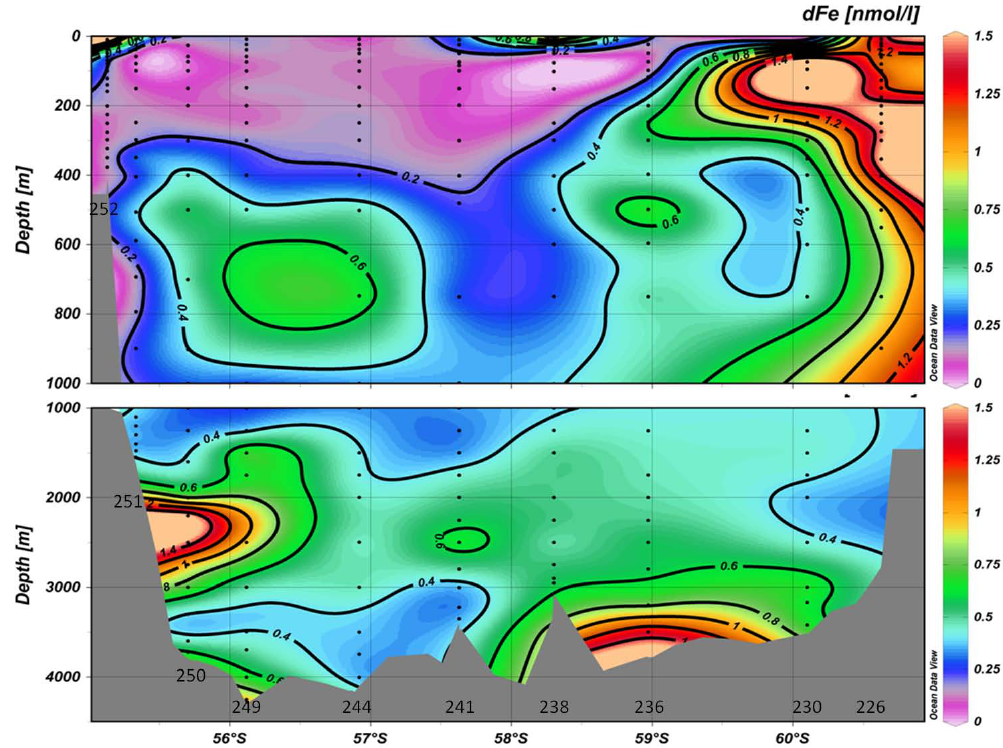
Fig. 5a. Section plot of DFe concentrations in the Drake Passage transect. station numbers 226–251 along horizontal axis.